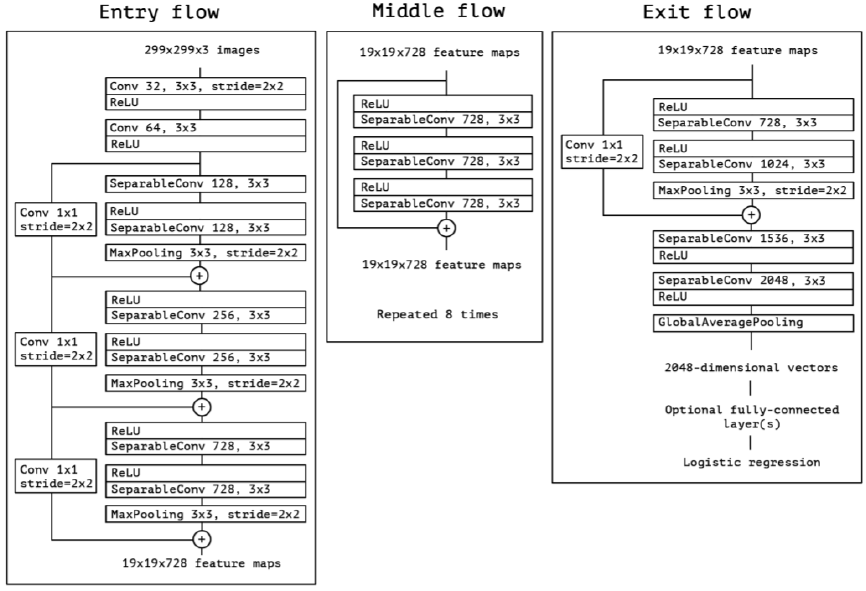
Figure 10. Architecture of the Xception model (Reprinted from ref. [12]).